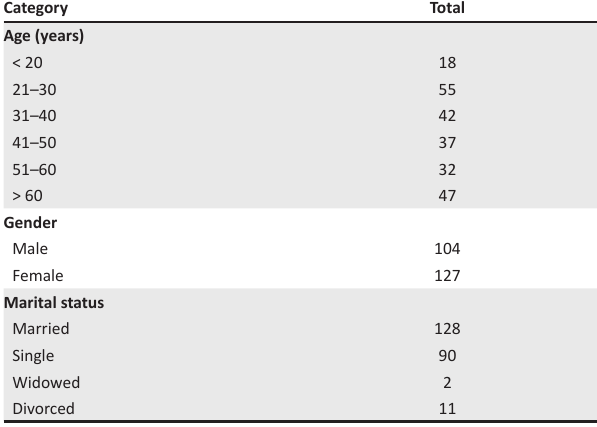
TABLE 1: List of primres used and the amplicon size. No. Target